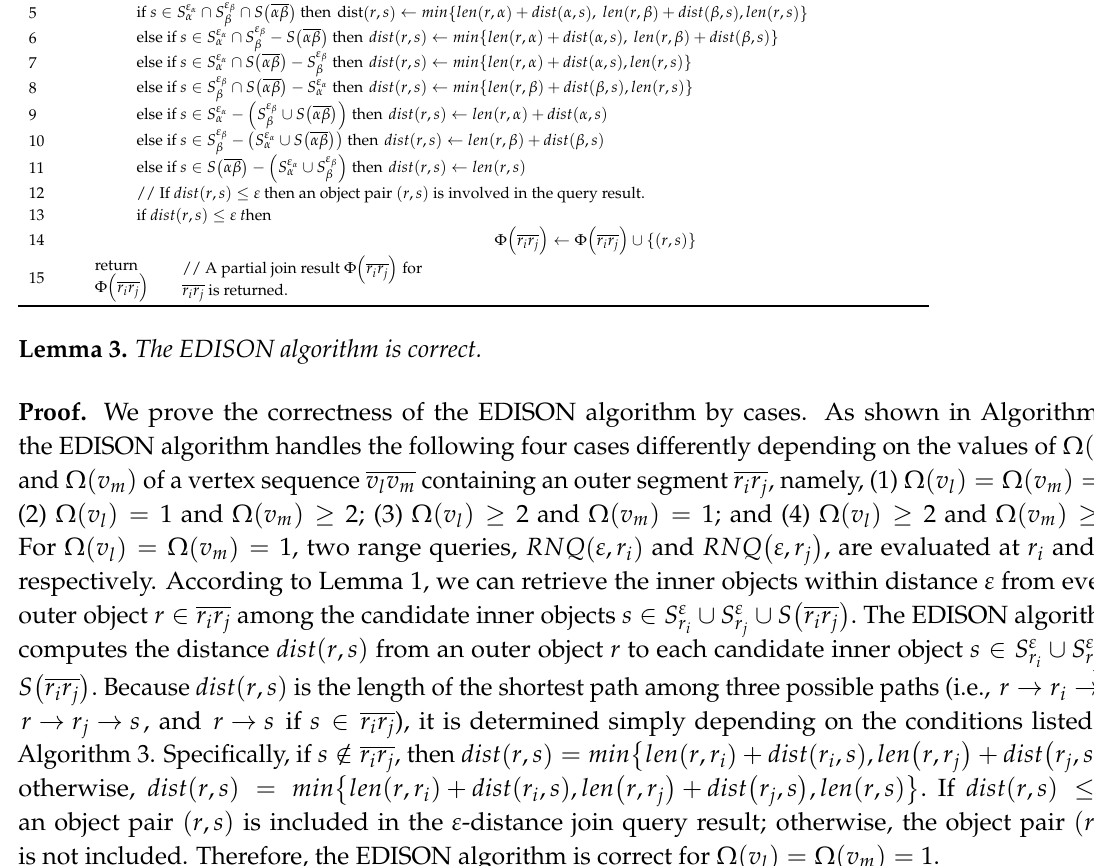
Algorithm 3: DJQ